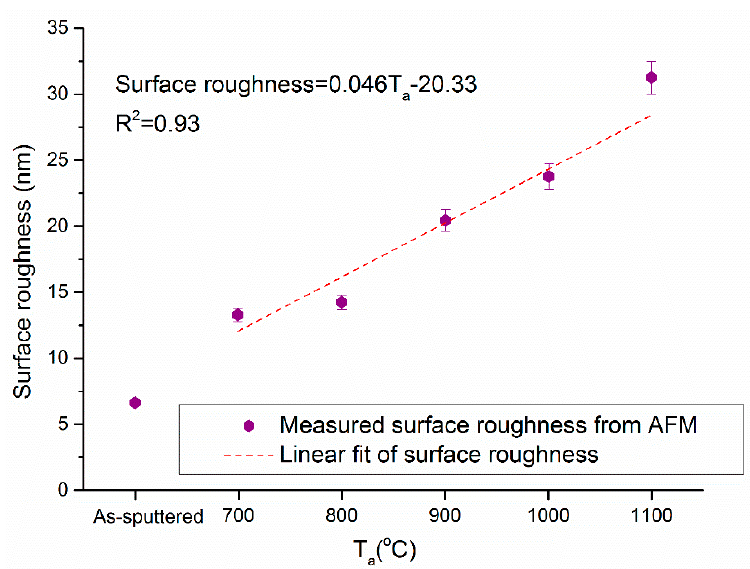
Figure 3. Surface roughness of Mo thin films, as a function of annealing temperature. Linear fit of measurement data from 700 ℃ to 1100 ℃ is also demonstrated.